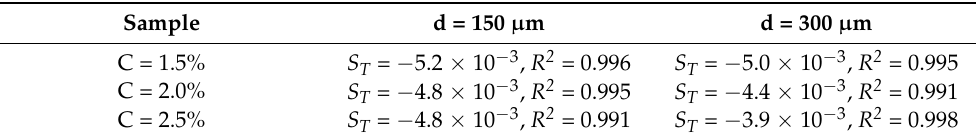
Figure 4. Typical fluorescence images obtained from a 300 μ m thick membrane with 2.5% concentration (140 mW LD optical power) at temperatures of ( a ) 25 °C, ( b ) 50 °C and ( c ) 100 °C. ( d ) Changes in normalized intensity for the same membranes as a function of temperature; the dots indicate the experimental measurements obtained by image analysis, and the solid line represents the linear fit of the experimental points. Table 1. Temperature sensitivities ( S T , °C − 1 ) and linearity ( R 2 ) of the normalized fluorescence intensities obtained for the PDMS-YbEr composite membranes.